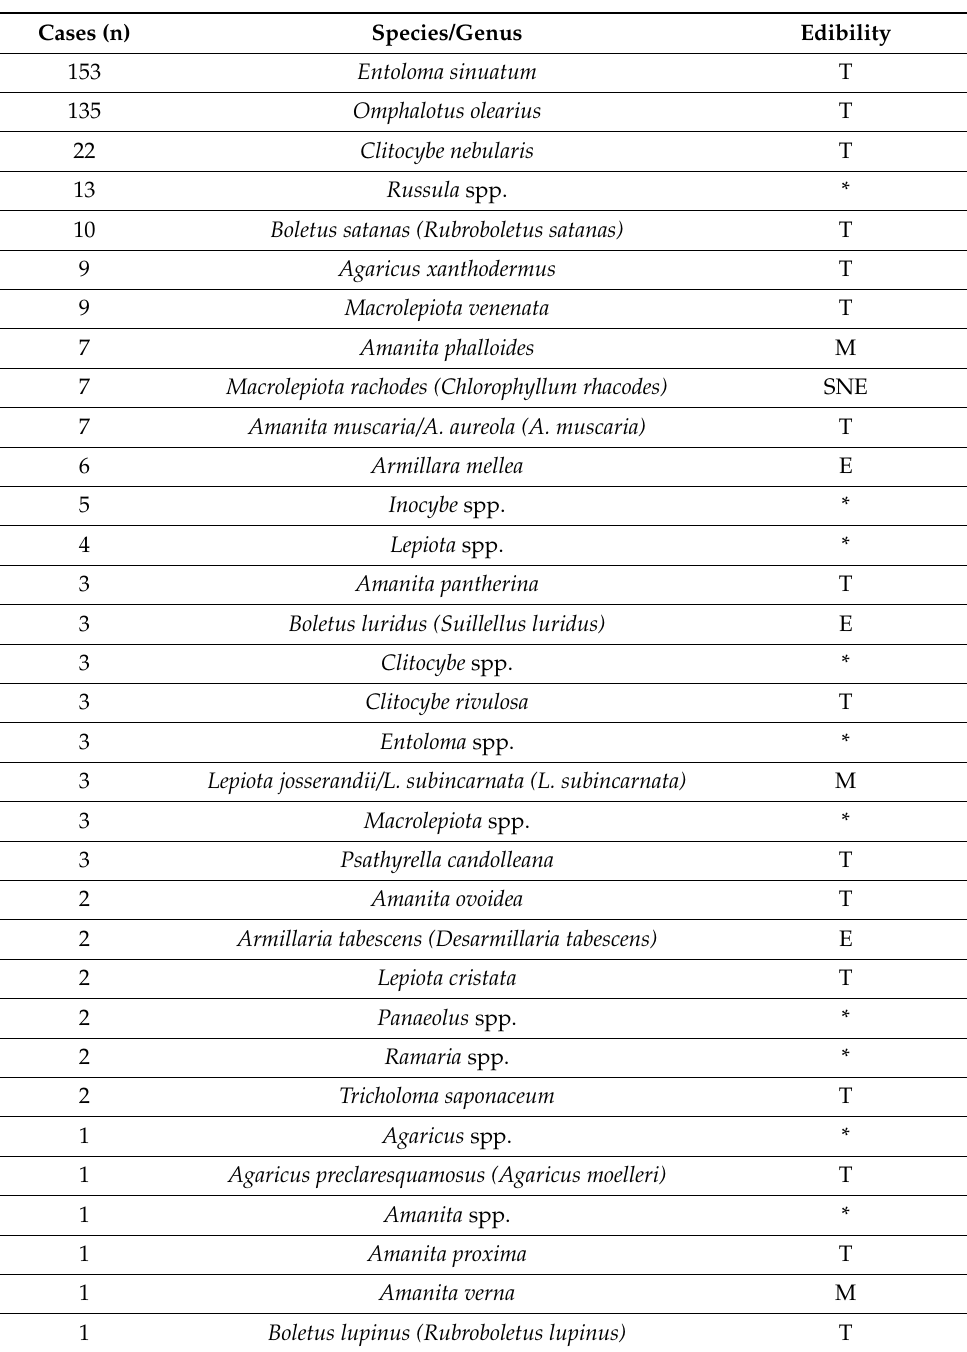
Table 1. List of mushroom poisoning cases that occurred in Tuscany during the ten-year period 2007 to 2017. The number of cases and the involved species/genus are reported. Obsolete nomenclatures are integrated with currently valid scientific names (in brackets) according to Index